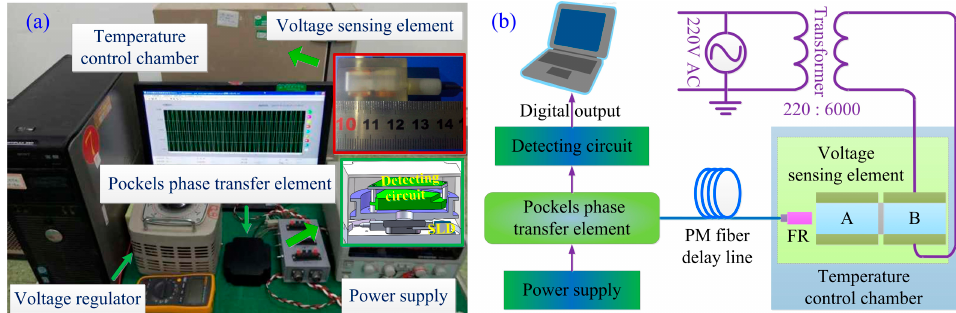
Figure 9 . ( a ) Experimental OVS prototype; ( b ) schematic diagram of experiment.